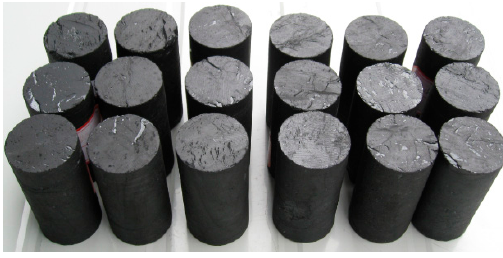
Figure 1. Photographs of part coal specimens.